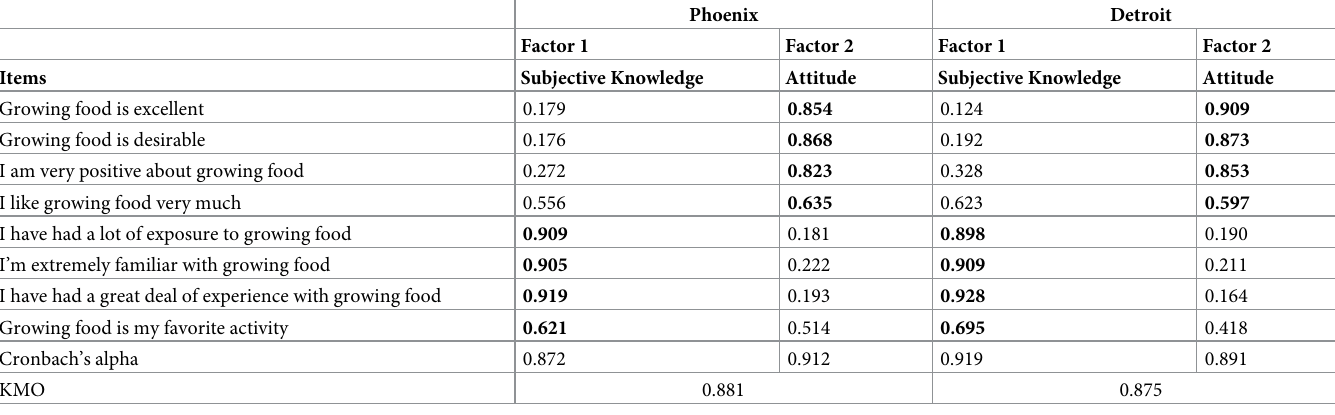
Table 3. Factor analysis of subjective knowledge and attitudes towards growing food (rotated factor loadings